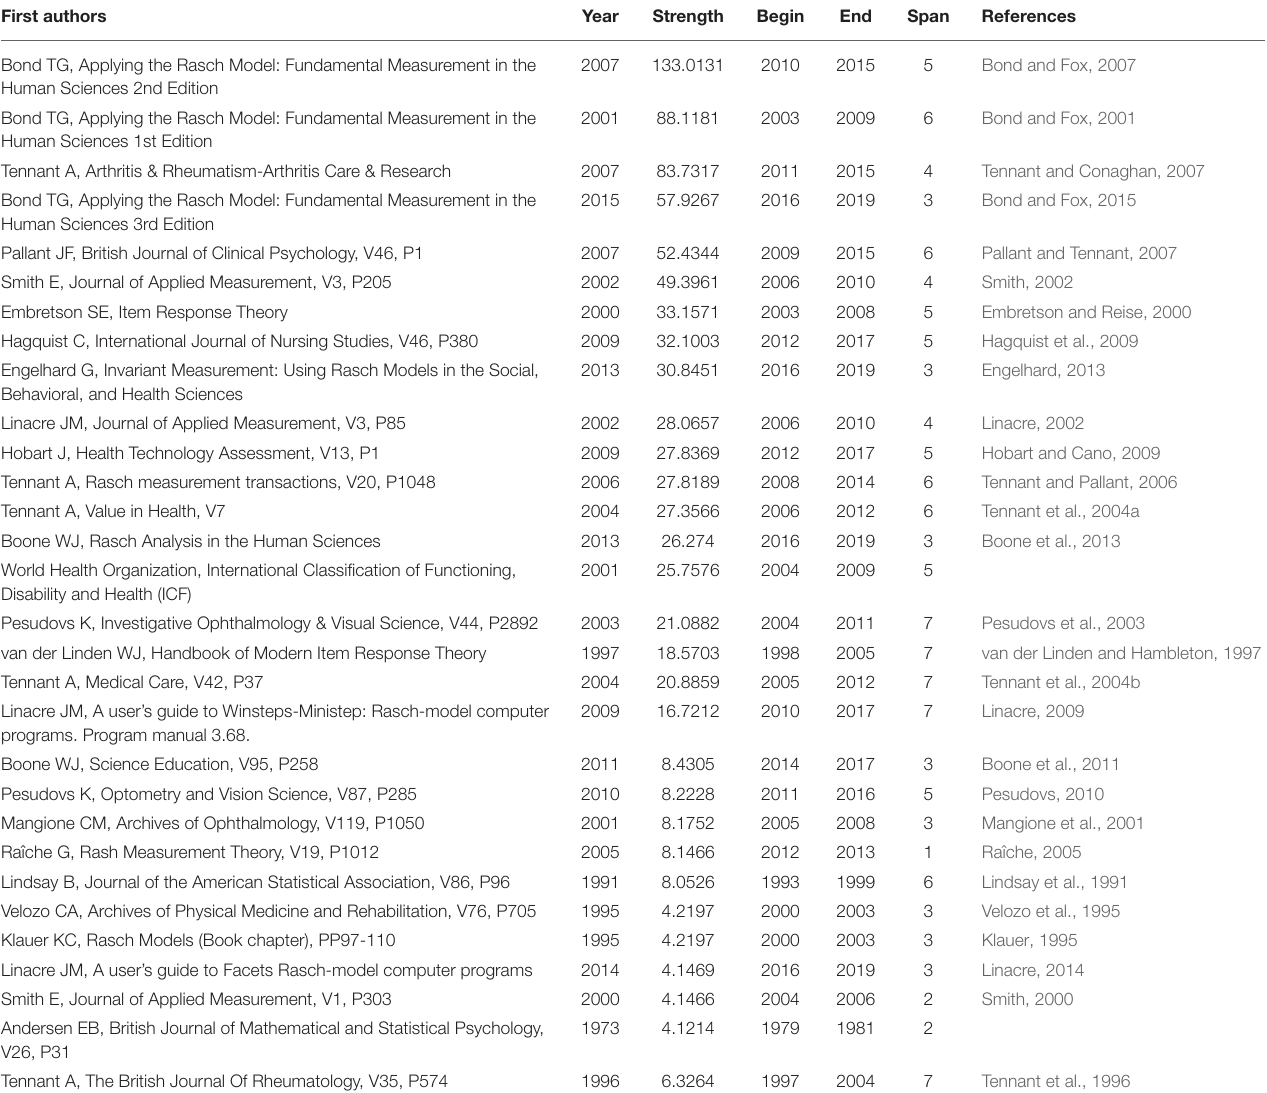
TABLE 2 | Sample document bursts computed via document co-citation analysis